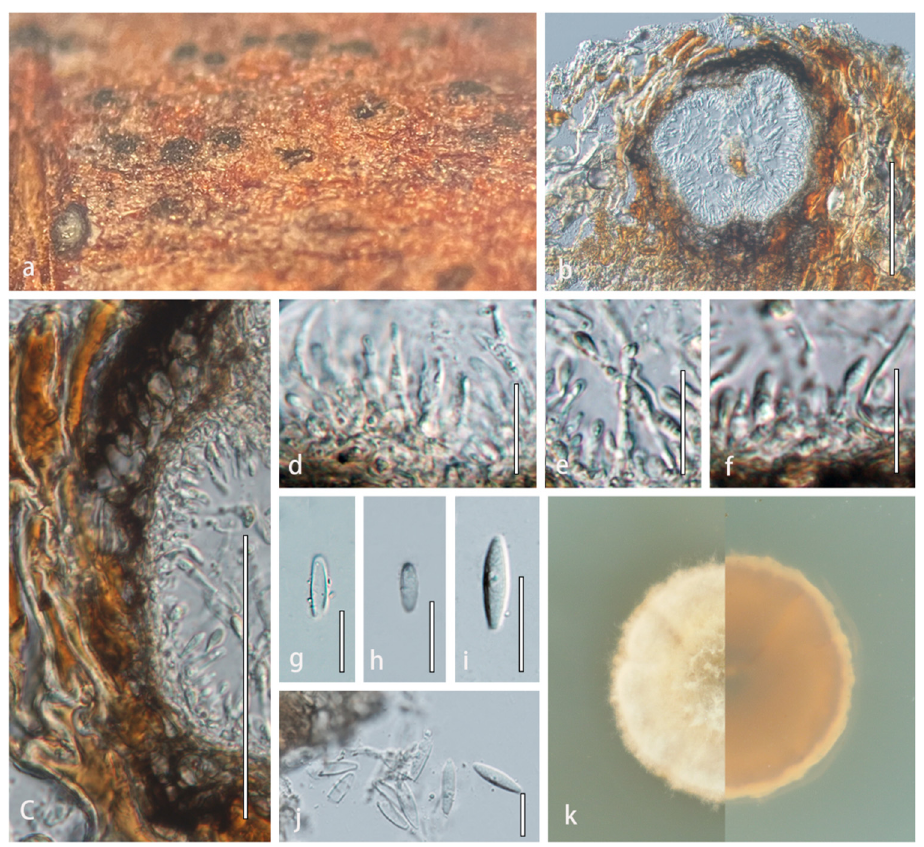
Figure 3. Angularia xanthoceratis (HMJAU 60197, holotype ). ( a ) Appearance of conidiomata on host substrate. ( b ) Vertical section of conidioma. ( c ) Section of conidioma wall. ( d – f ) Conidiogenous cells and conidia. ( g – j ) Conidia. ( k ) Culture characteristics on PDA after two weeks at 25 °C. Scale bars: